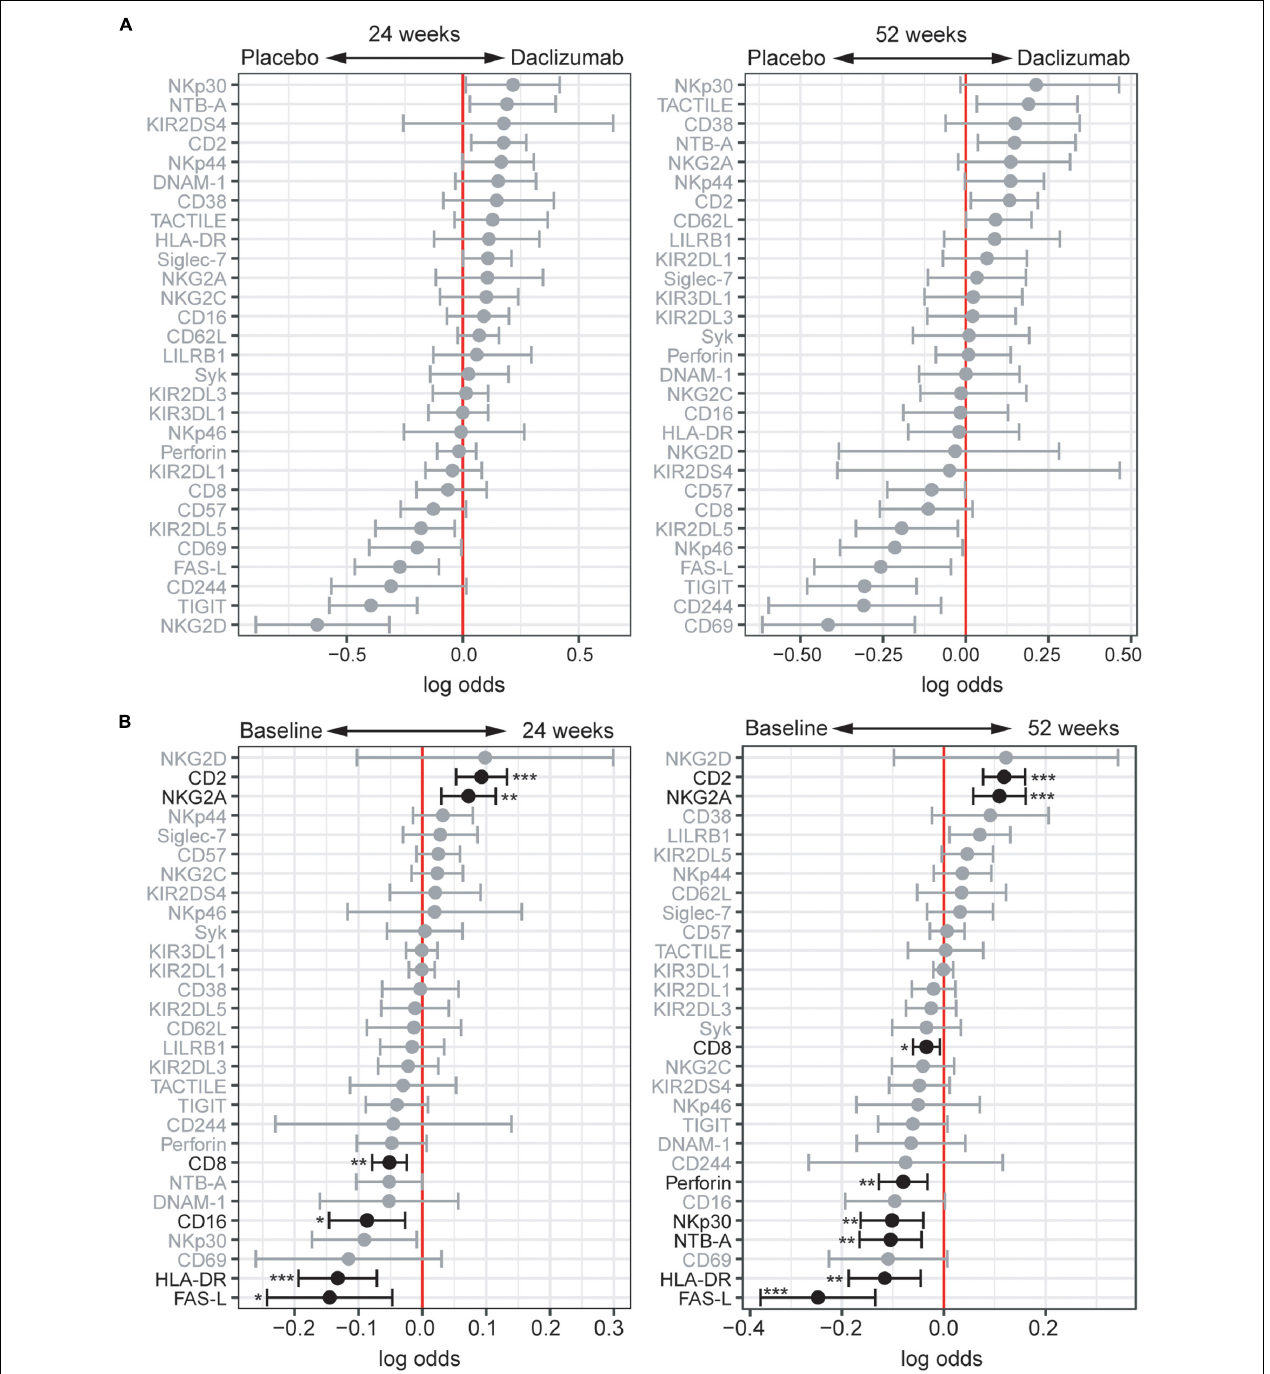
FIGURE 4 | Daclizumab beta changes NK receptor expression on CD56 dim cells distinctly from CD56 bright cells. (A) A generalized linear model with bootstrap resampling was used to identify NK markers on CD56 dim NK cells predictive of daclizumab beta- and placebo-treated individuals at 24 (left) and 52 (right) weeks of treatment. CD56 dim NK cells were used with subsampling to 1000 cells per individual. Placebo: 24 weeks, n = 14; 52 weeks, n = 16. Daclizumab beta: 24 weeks, n = 25; 52 weeks, n = 27. Gray lines indicate markers with adjusted p -values > 0.05. Black lines indicate markers with adjusted p -values < 0.05. (B) A generalized linear mixed model with paired comparison was used for analyses of the same individual over time, comparing baseline and 24 weeks of daclizumab beta treatment (left), and baseline and 52 weeks of daclizumab beta treatment (right). CD56 dim NK cells were used with no subsampling. Daclizumab beta baseline vs. 24 weeks, n = 21. Daclizumab beta baseline vs. 52 weeks, n = 22. *Adjusted p -value < 0.05, **adjusted p -value < 0.01, ***adjusted p -value < 0.001. Adjusted p -values calculated using Benjamini-Hochberg method with FDR = 0.05.